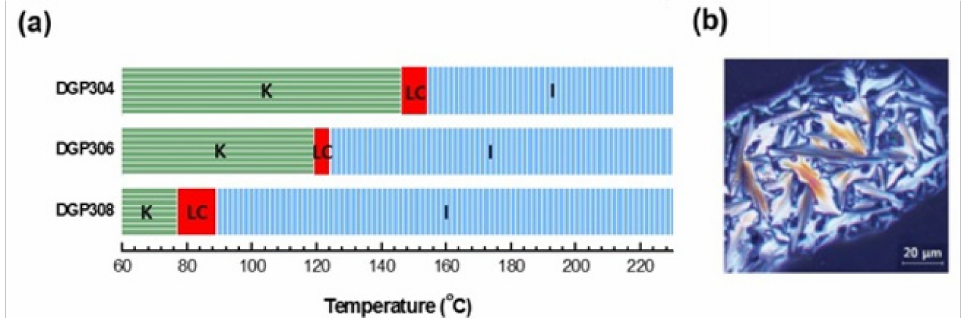
Figure 9. ( a ) The transition temperature of DGP30 n ( n = 4, 6, 8) and ( b ) DGP308 (cid:48) s polarization microscopy (POM) images. Reproduced from Ref. [31] with permission from The Royal Society of Chemistry.